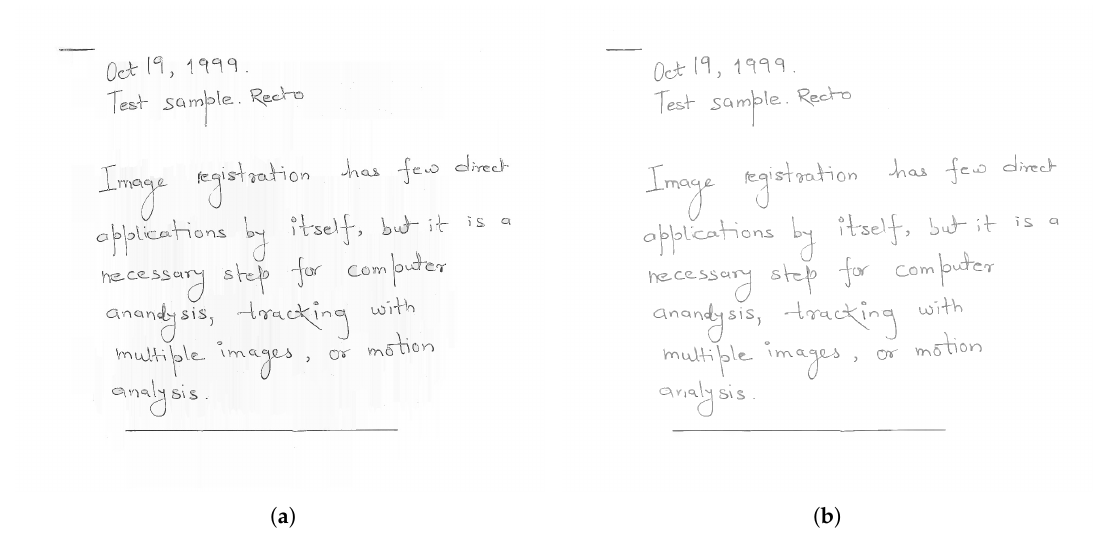
Figure 11. Comparison of our method to a blind method in scan-through removal. ( a ) Nishida and Suzuki [43] with S = 2 7 , λ = 130; ( b ) ours with λ = 70, α = 255, σ =